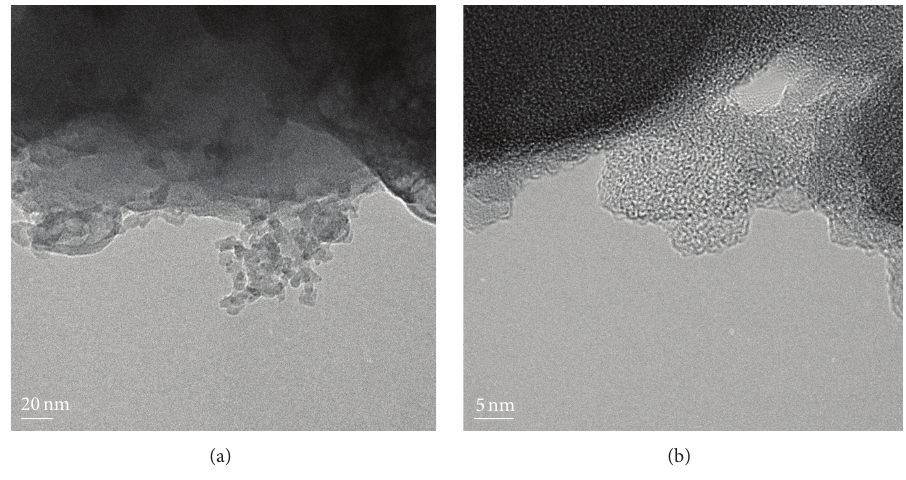
Figure 1: (a) TEM and (b) HRTEM images showing